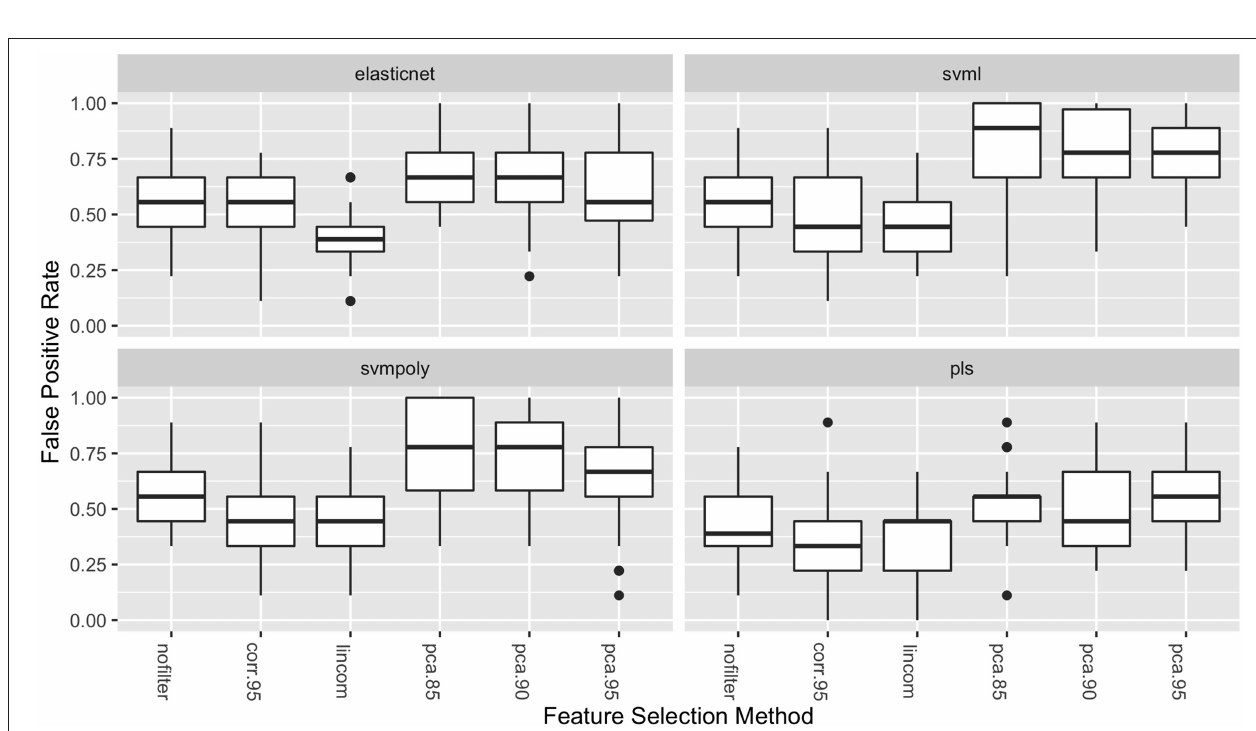
FIGURE 3 | Boxplots of the false positive rates (over the 50 repeated cross-validation testing sets) for each feature selection method for the four best-performing classifiers.